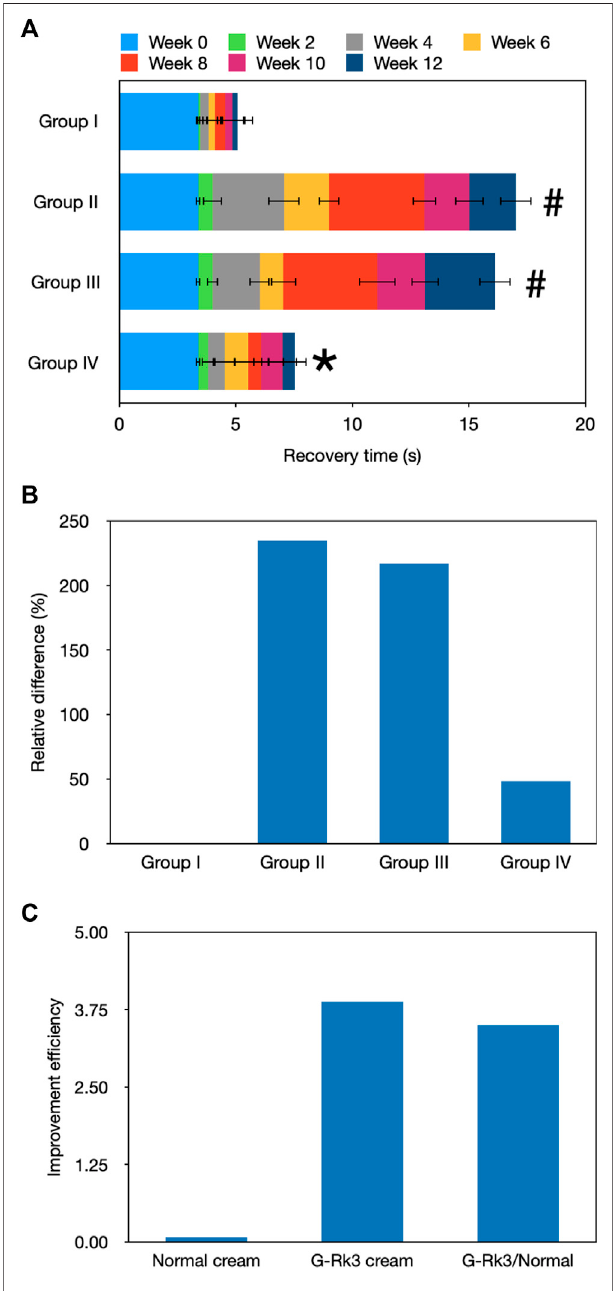
FIGURE 3 | Evaluation of recovery from stretching. Recovery time (A) . The absolute value of the recovery time in the initial state (0 weeks) was used. In other weeks, only the increment per 2 weeks is shown. #Signi fi cantly different from group I, p < 0.05. *Not different from group I, p > 0.05. Relative differences in the four groups (B) . Improvement ef fi ciencies of normal and G-Rk3 creams (C) .